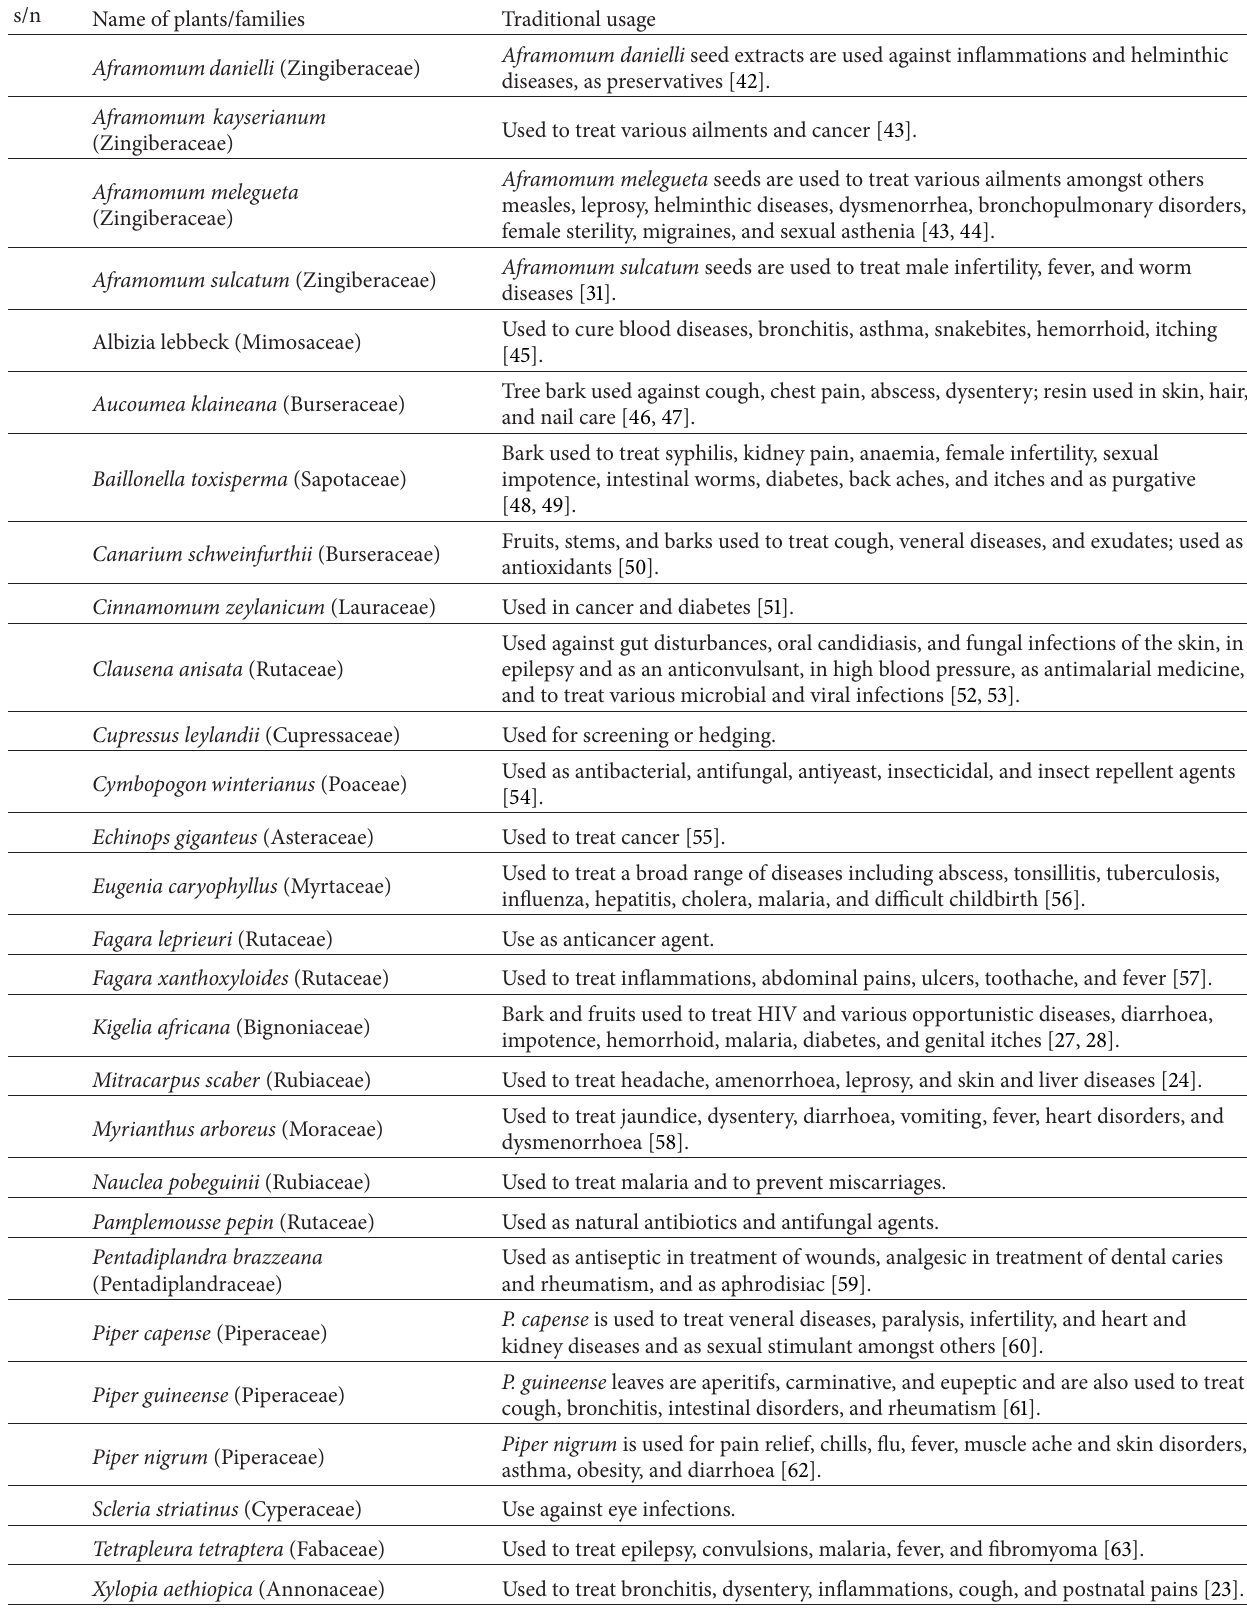
Table 1: Selected ethnomedicinal plants (from the Bassa land, Cameroon) used in the study and their traditional usage. s/n Name of